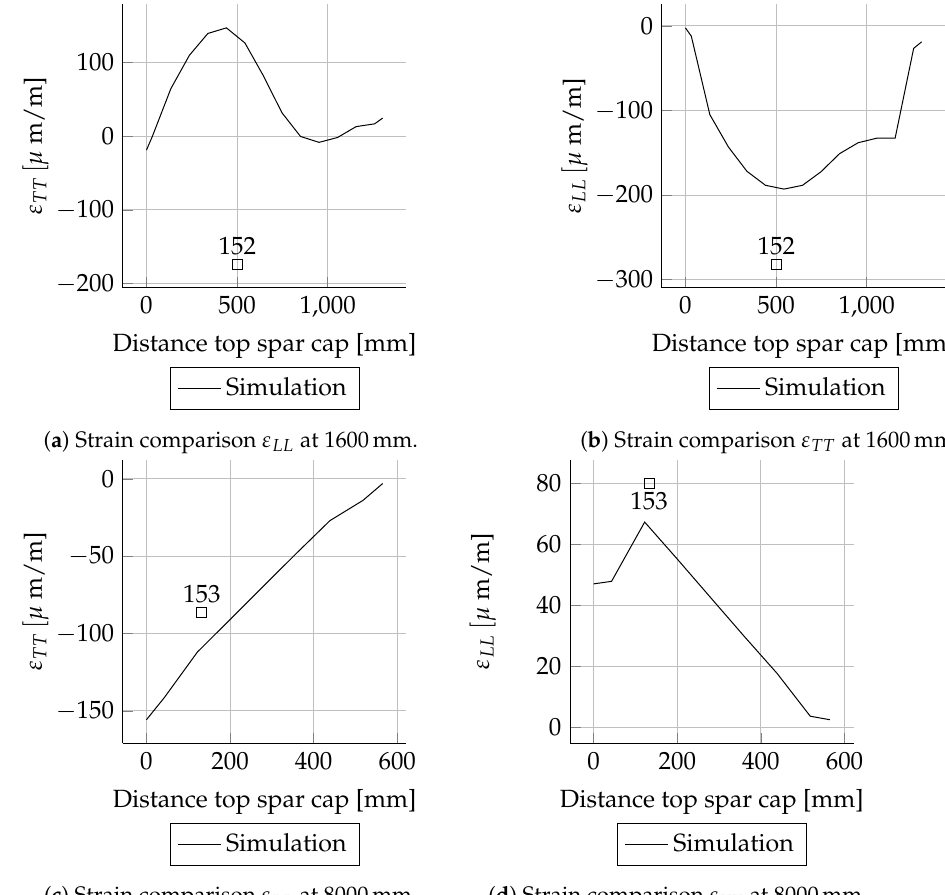
( c ) Strain comparison ε LL at 8000mm. ( d ) Strain comparison ε TT at 8000mm. Figure A13. Cont